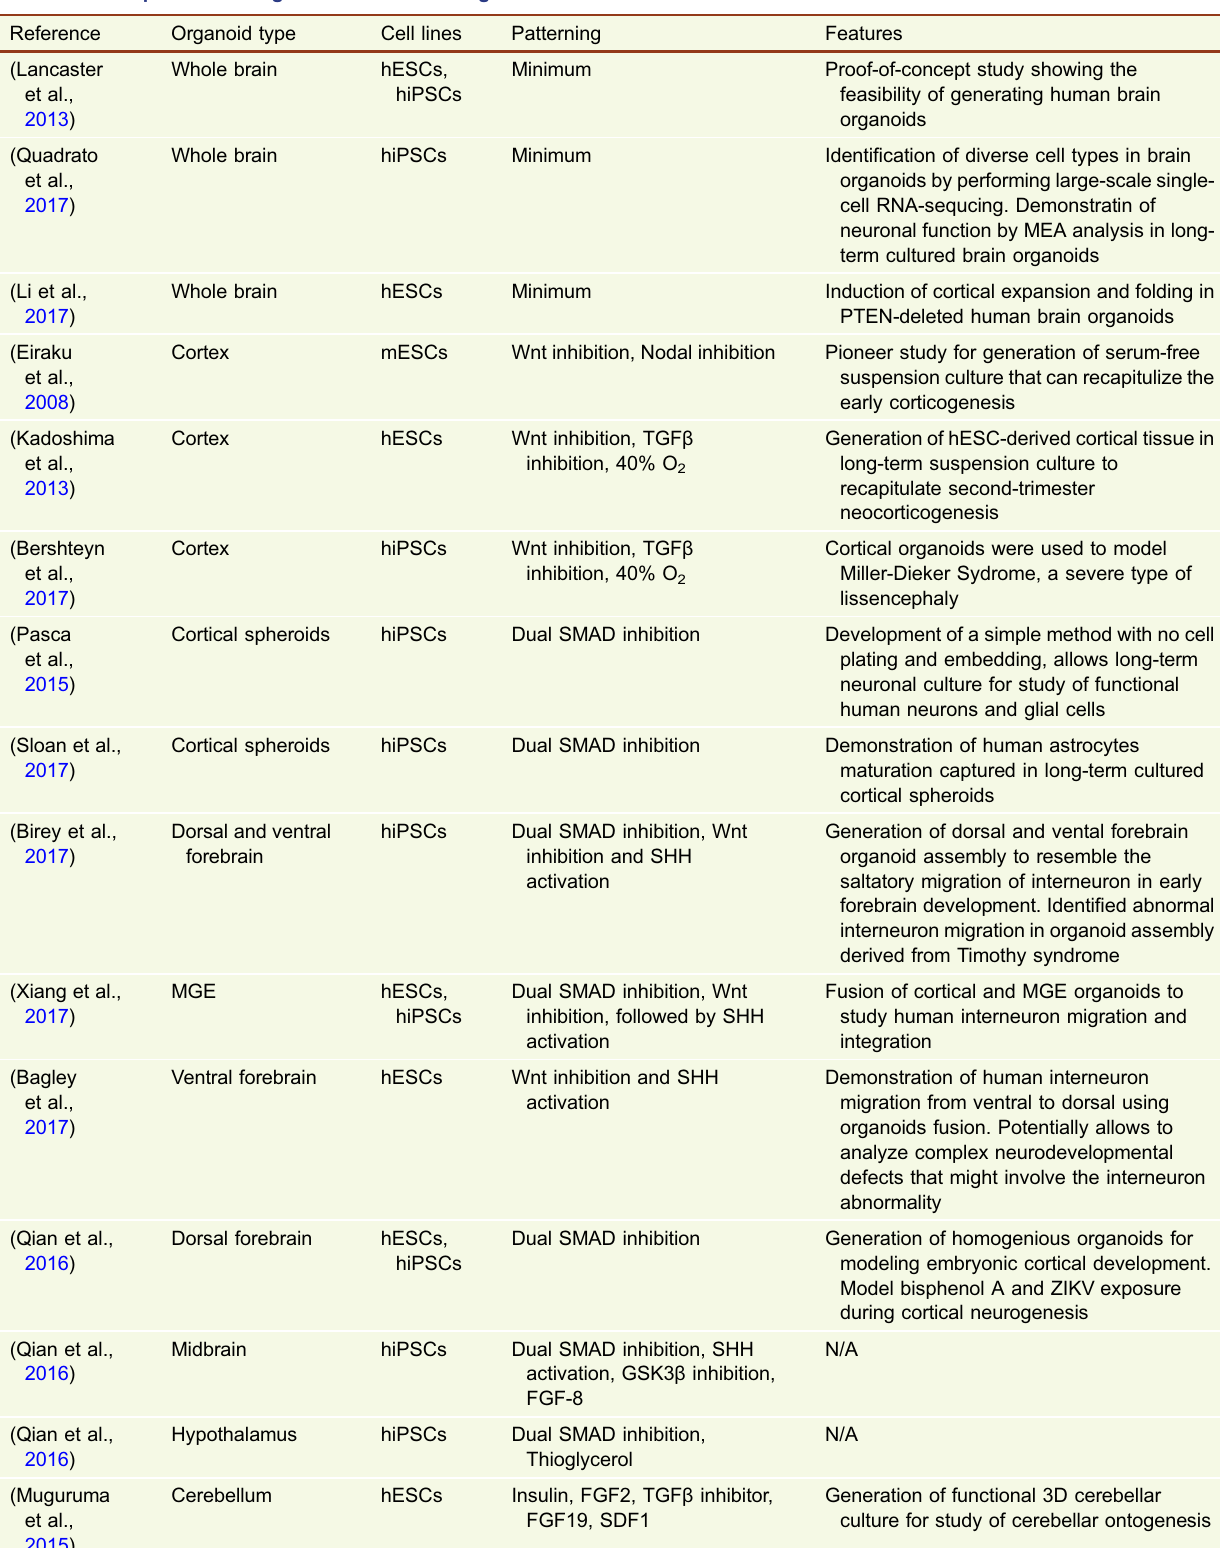
Table 2. Select protocols for generation of brain